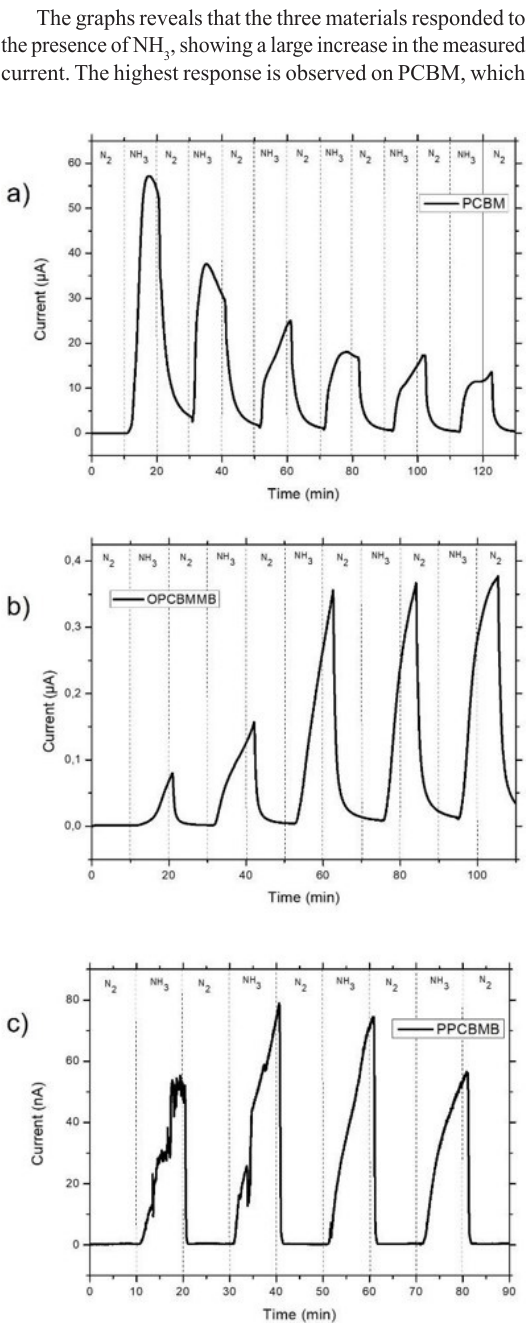
Figure 5. I vs t curves for the sensor devices with Drop casting films of: a) PCBM; b) OPCBMMB; c) Table 1. Current peaks observed at each cycle for the studied materials. Current peaks